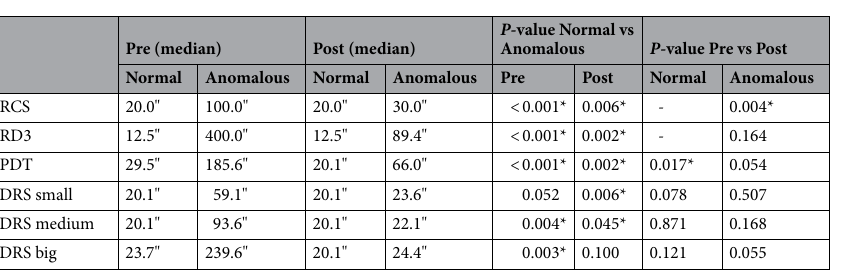
Table 1. Pre and post median stereoacuity thresholds for each group and stereoacuity test and statistical mean comparison ( P -value).